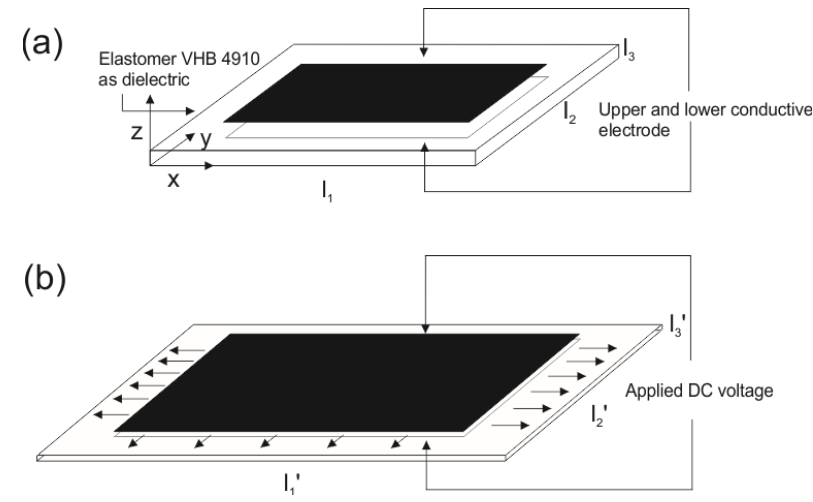
Figure 1. Basic structure of a planar DEA: ( a ) deactivated state and ( b ) activated state. The basic principles of DEAs’ movement are not the same as for biological muscles, but, in comparison with ionic actuators, they move much faster and exhibit larger movements. Under applied voltage they can also hold the tension or position. As such, they can be used as soft actuators with similar behavior as biological muscles.